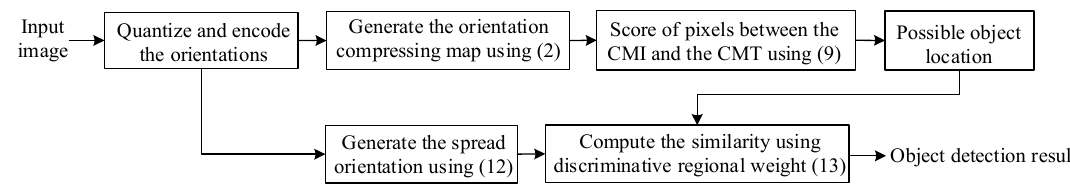
Figure 7. Block-diagram of OCM-DRW algorithm.